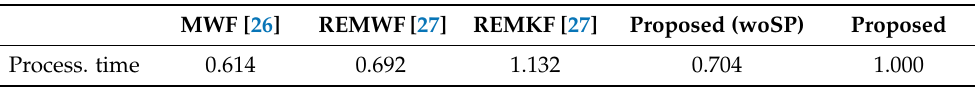
Table 6. Comparison of the normalized processing time when the a priori SPP was obtained by a